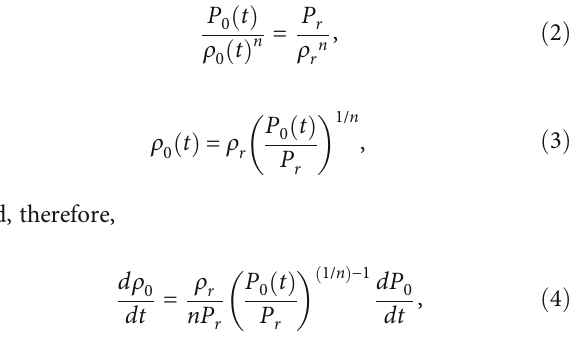
= 40 Hz (i.e., mean fl ow speed U ̲